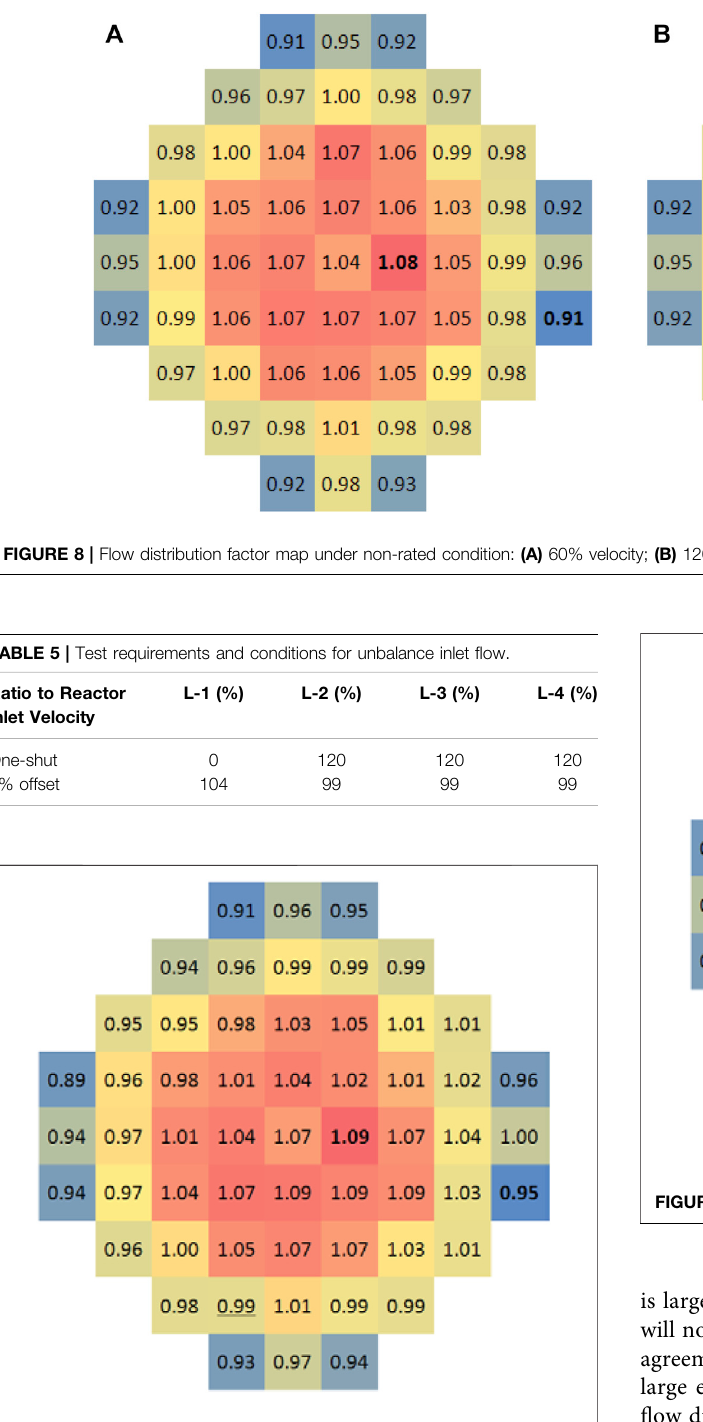
FIGURE 9 | Flow distribution map under one-shut condition.